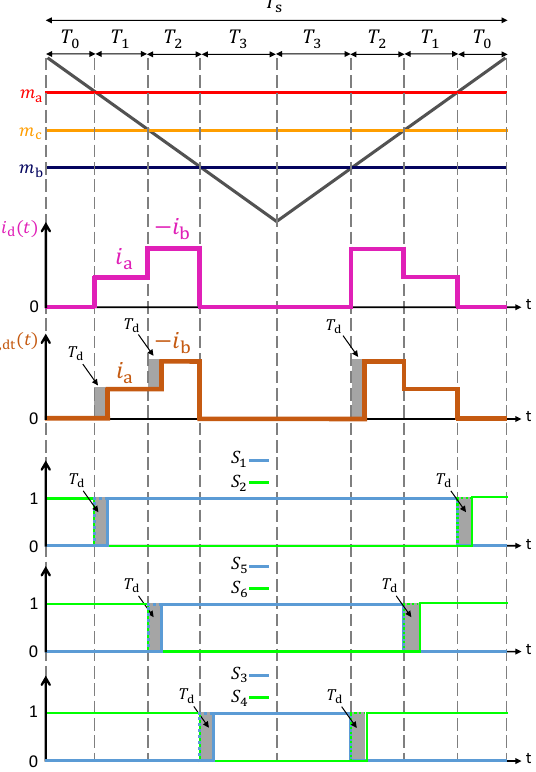
Figure 2. Example of input current waveform of a three-phase VSI over a carrier period without ( i d )/with the influence of dead-time ( i d,dt ) and the gating signals of the